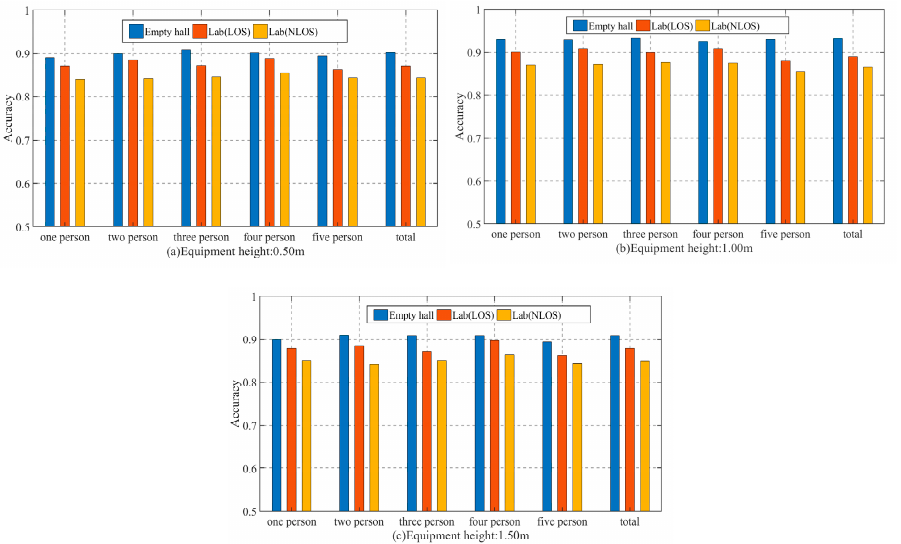
Figure 9. The impact of equipment height on accuracy in different environments. ( a ) Equipment heights: 0.50 m, ( b ) Equipment heights: 1.00 m, ( c ) Equipment heights: 1.50 m.